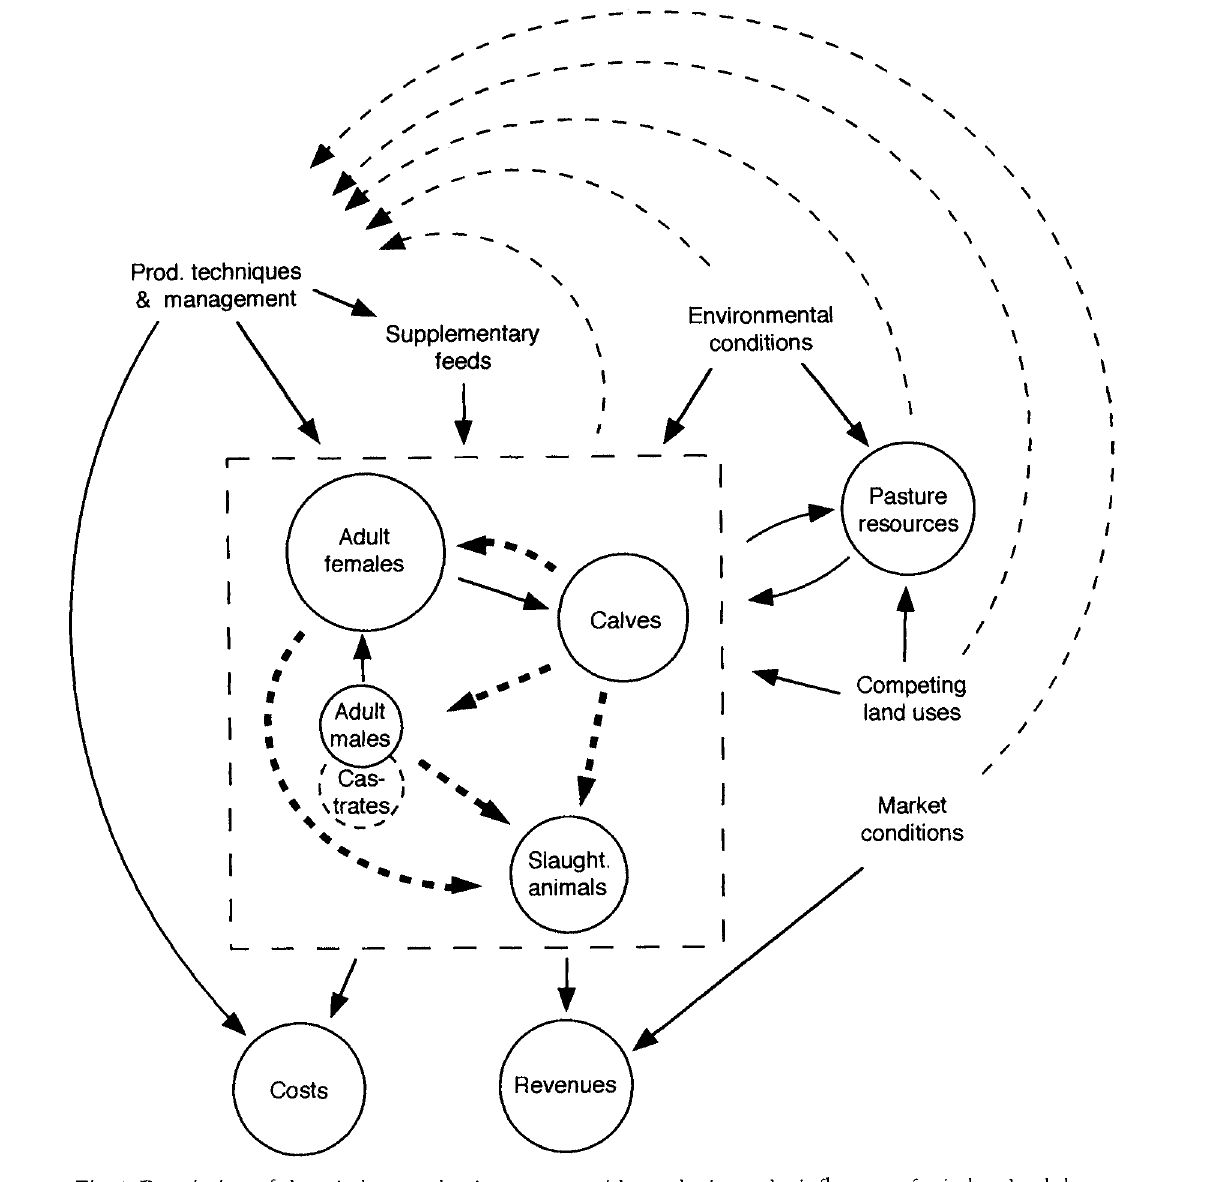
Fig. 1. Description of the reindeer production system, with emphasis on the influences of reindeer herd dyna mics on productivity. The subsystem is delimited by the dashed lines. Solid arrows represent direct ef fects of one component on another, whereas dashed arrows indicate possible influences, which are consi dered indirect in this context. Broken bold arrows within the herd box represent transitions in the status of animals over